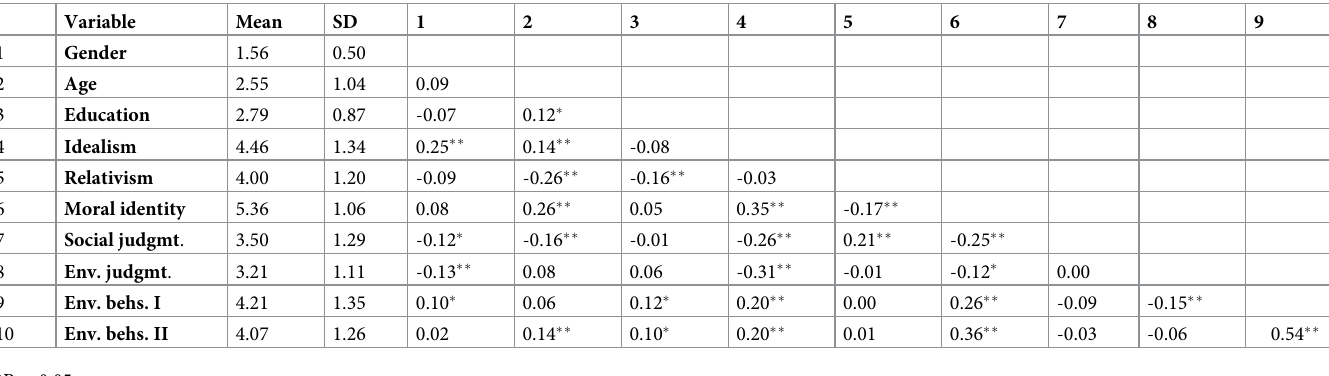
Table 4. Descriptive statistics and intercorrelations among study